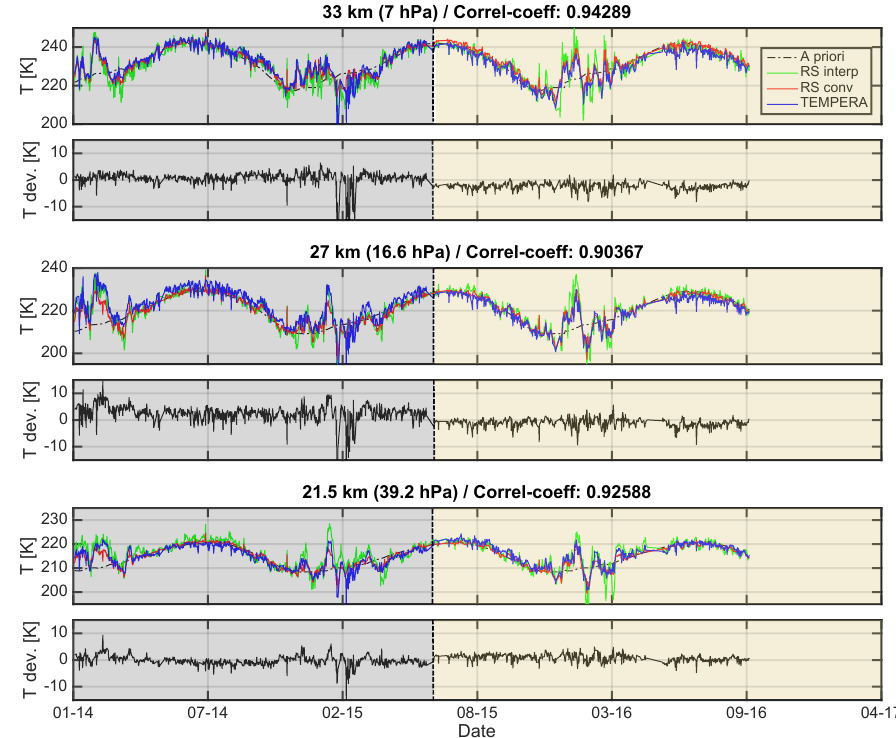
Figure 7. Stratospheric temperature evolution and temperature deviations at different altitudes for RS and TEMPERA. Different background colours are used to distinguish between period 1 and 2 (grey and light brown,